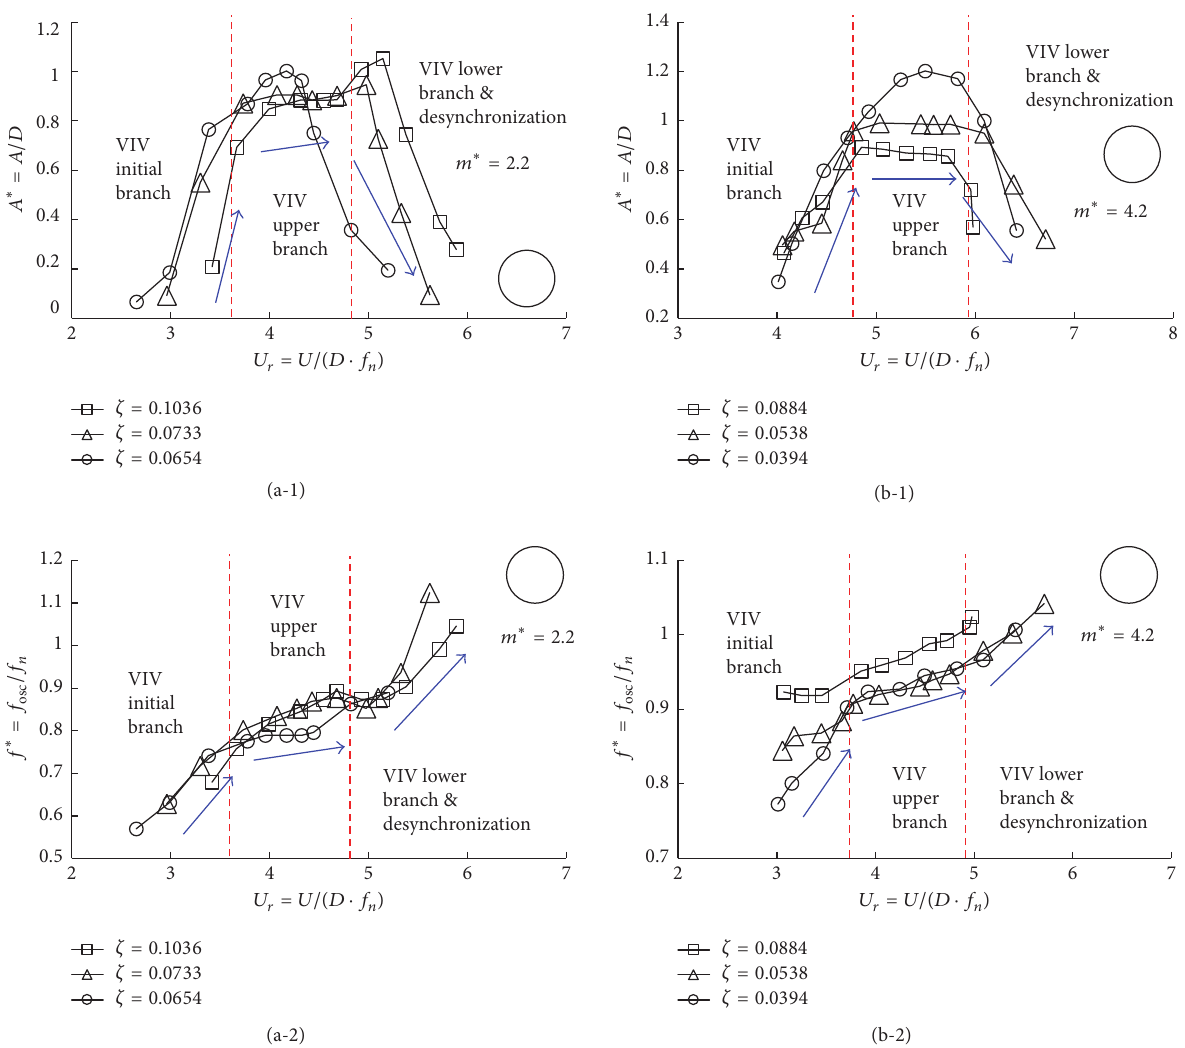
Figure 7: Variations of the amplitude ratios and the frequency ratios against the reduced velocities for circular cylinders. Amplitude ratio 𝐴 ∗ = 𝐴/𝐷 ; frequency ratio 𝑓 ∗ = 𝑓 the natural frequency. (a-1) The responses of amplitude ratios, 𝑚 ∗ = 2.2 ; (a-2) the responses of frequency ratios, 𝑚 ∗ = 2.2 ; (b-1) the responses of amplitude ratios, 𝑚 ∗ = 4.2 ; (b-2) the responses of frequency ratios, 𝑚 ∗ = 4.2 .